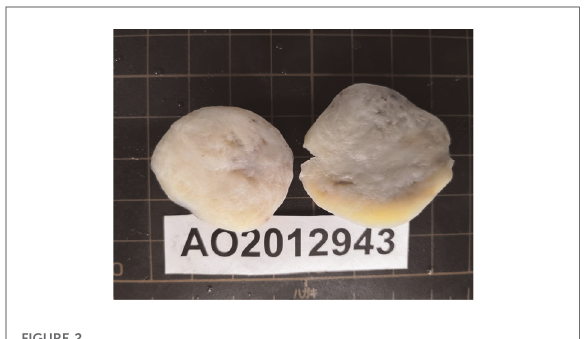
FIGURE 2 Macropathology of metastasizing leiomyoma. The leiomyoma appeared as a solid, tough, grayish-white tubercle with no exact capsule.